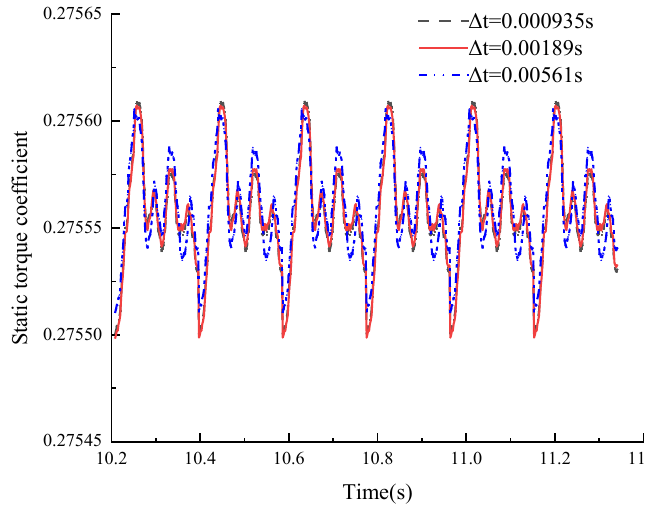
Figure 5. Time independence results.